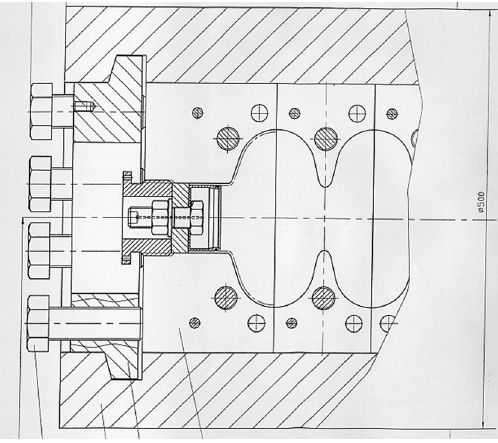
FIG. 19. Schema of high pressure calibration device.